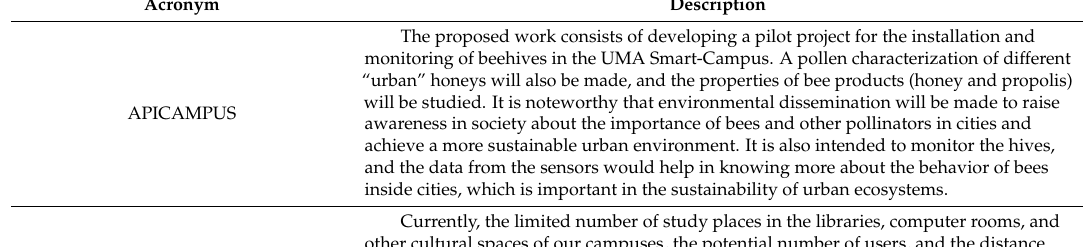
Table 3. Description of the selected projects in the Smart-Campus Innovation Plan.